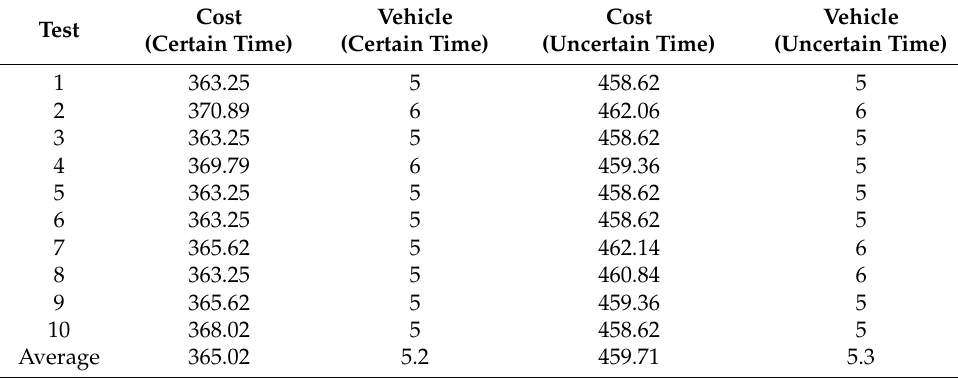
Table 6. Comparison of scheme costs for